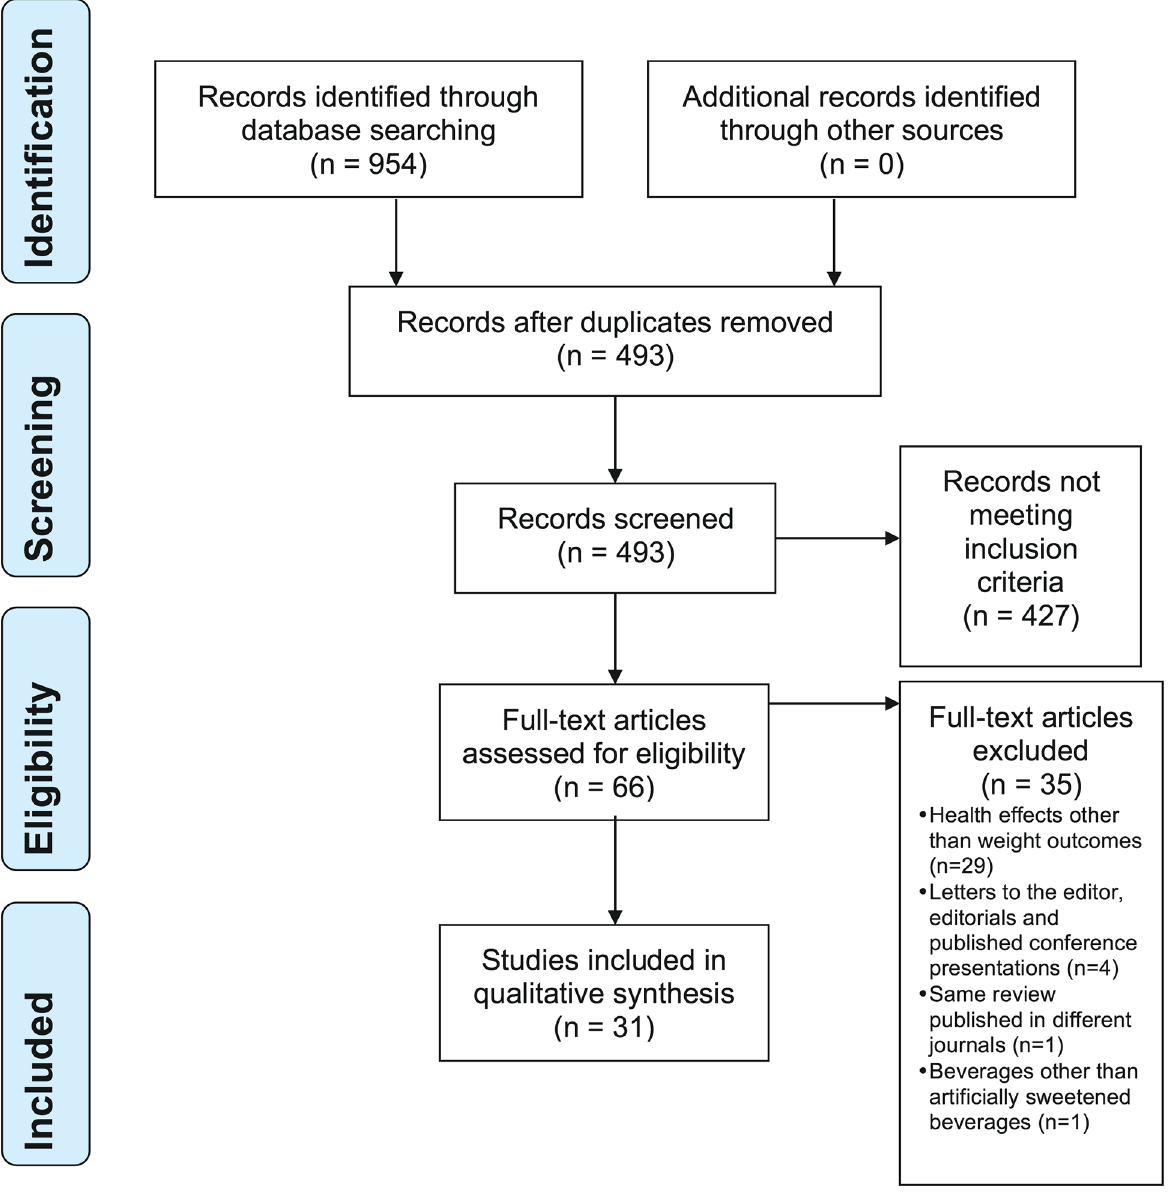
Fig 1. Prisma Flow